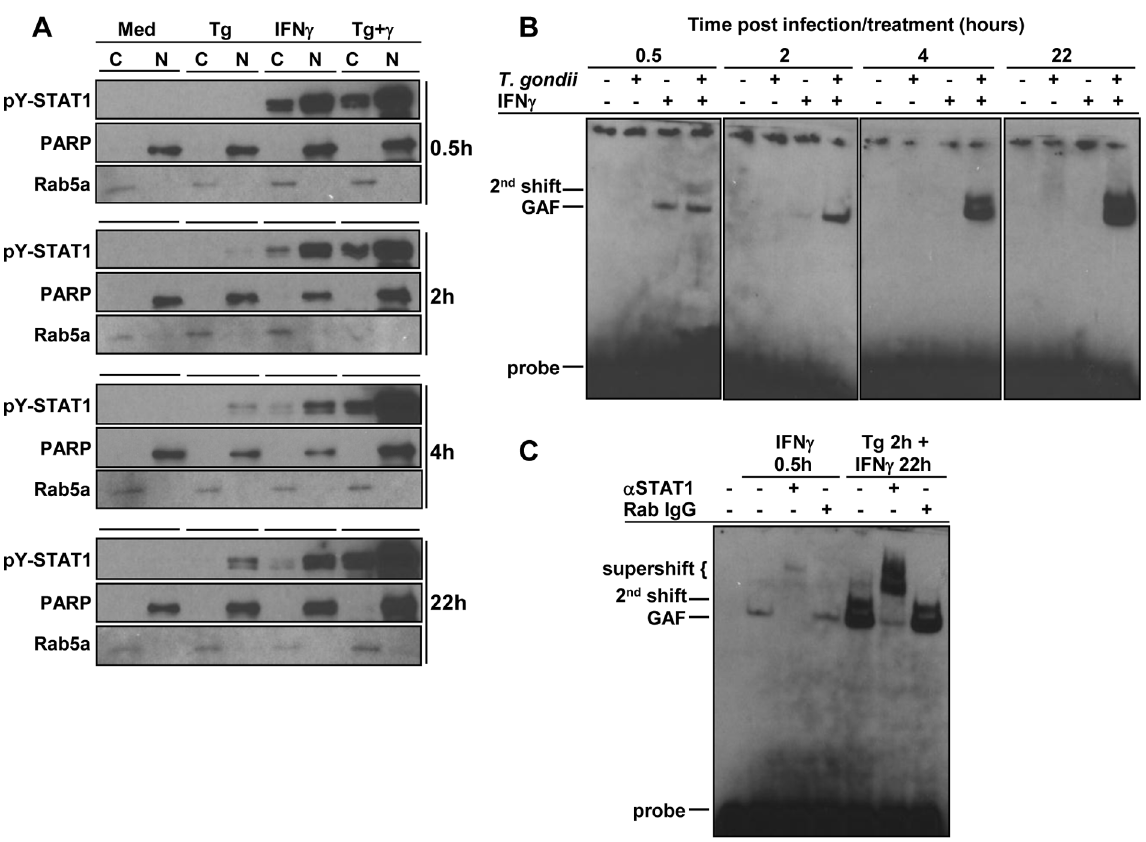
Figure 4. Toxoplasma synergizes with IFN c in terms of phosphorylation and in vitro binding activity of STAT1. BMDC were left in medium alone (Med), infected with Toxoplasma (Tg, RH strain) at a ratio of 3 parasites per cell, treated with IFN c (100 ng/ml), or infected with Toxoplasma followed 2 hours later by IFN c treatment for the indicated times. In (A), cells were fractionated into cytosolic (C) and nuclear (N) extracts prior to immunoblot analysis for phospho-Tyr701-STAT1 (pY-STAT1). PARP and Rab5a served as loading controls for nuclear and cytoplasmic fractions, respectively. In (B) and (C), nuclear extracts were tested for binding to biotinylated probes containing the gamma-activated sequence (GAS) from the Irf-1 promoter by EMSA. Supershift assays were also performed with samples in (C) using an antibody against STAT1 a or normal rabbit IgG as a negative control. Experiments were repeated at least three times with similar results. GAF, gamma-activated factor (STAT1 homodimer).